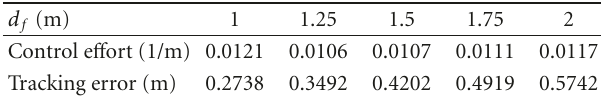
Table 3: Influence of d f for person following. d f (m) 1 1.25 1.5 1.75